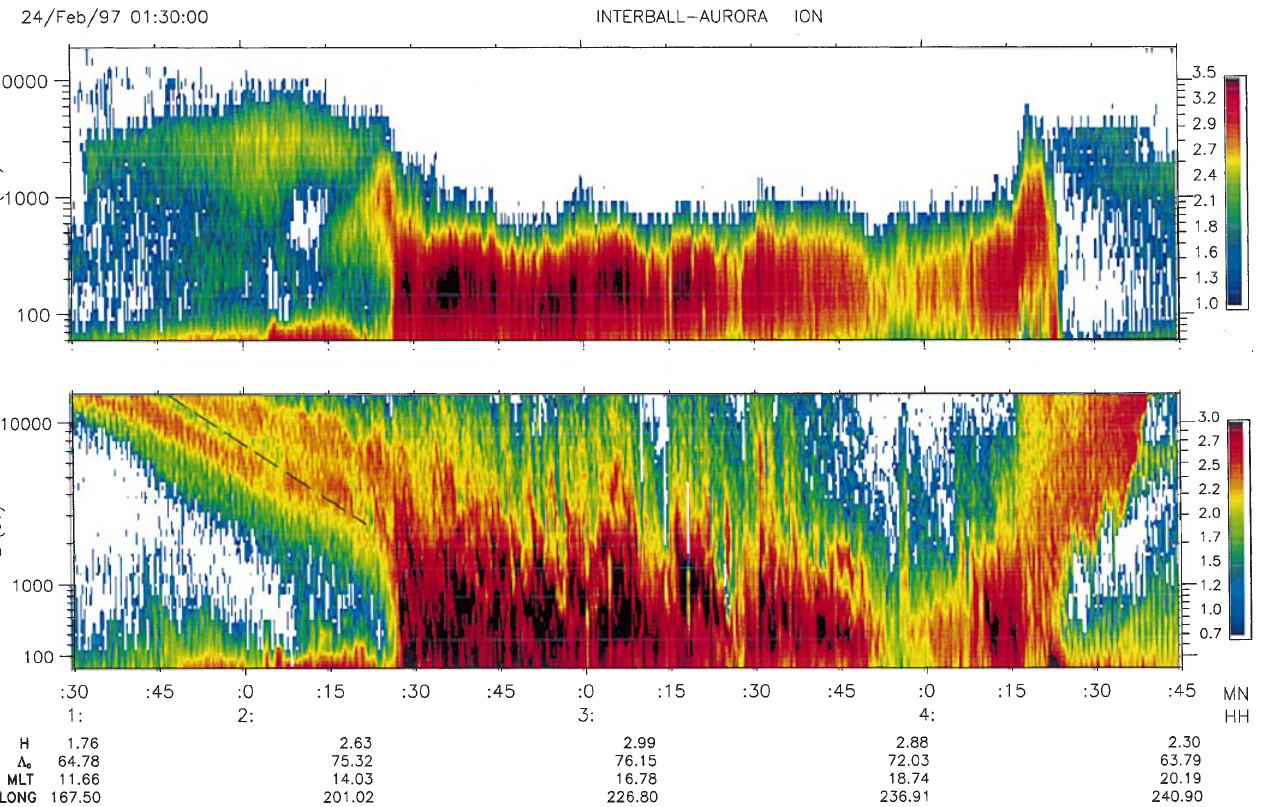
Fig. 7. Electron (top) and proton (bottom) energy-time spectrograms for a complete pass over the polar regions on 24 February 1997 between 01:30 and 04:45 UT. Energy fluxes are color coded. Note that between 02:15 and 04:30 UT the satellite was at altitudes greater than